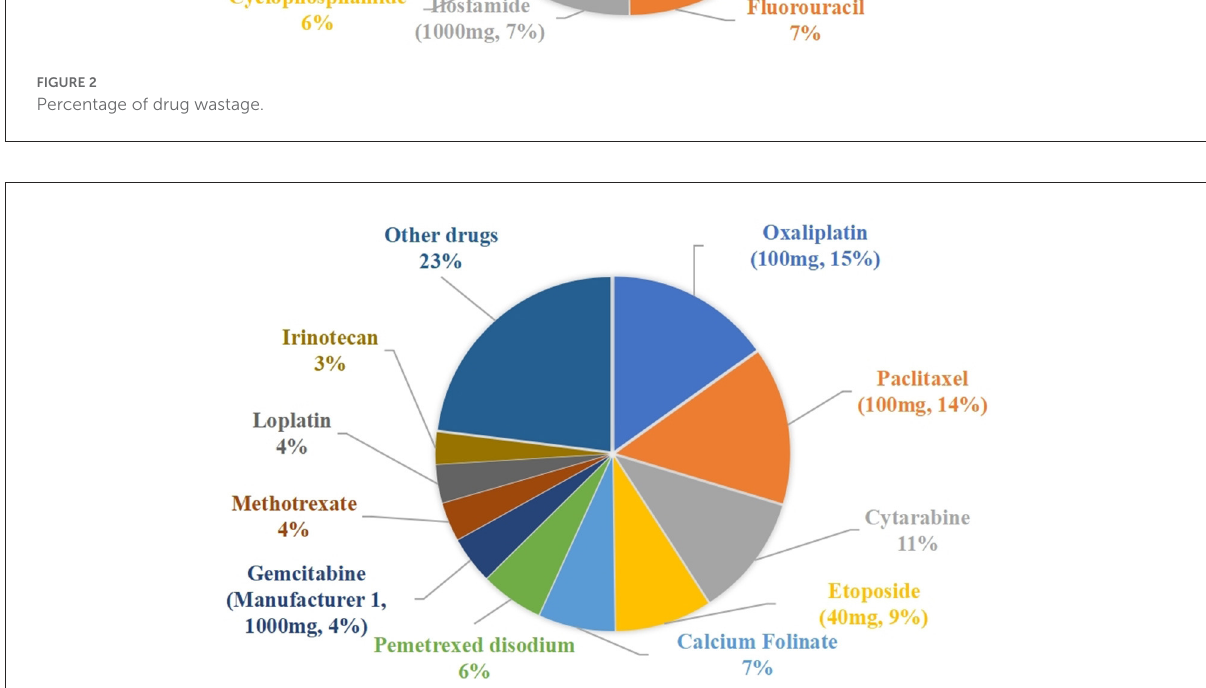
FIGURE3 Percentage of drug waste